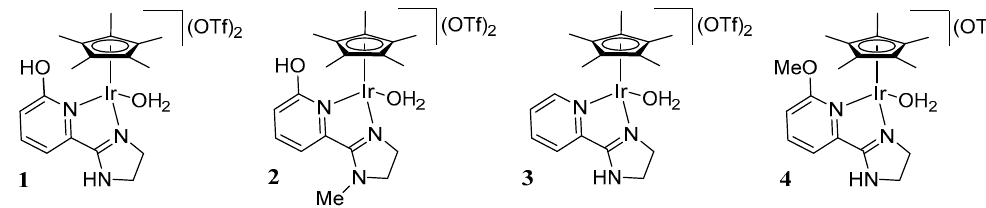
Figure 1. The dicationic complexes 1 – 4 bearing a bidentate ligand based on pyridine and 4,5-dihydro-1 H -imidazole-2-yl